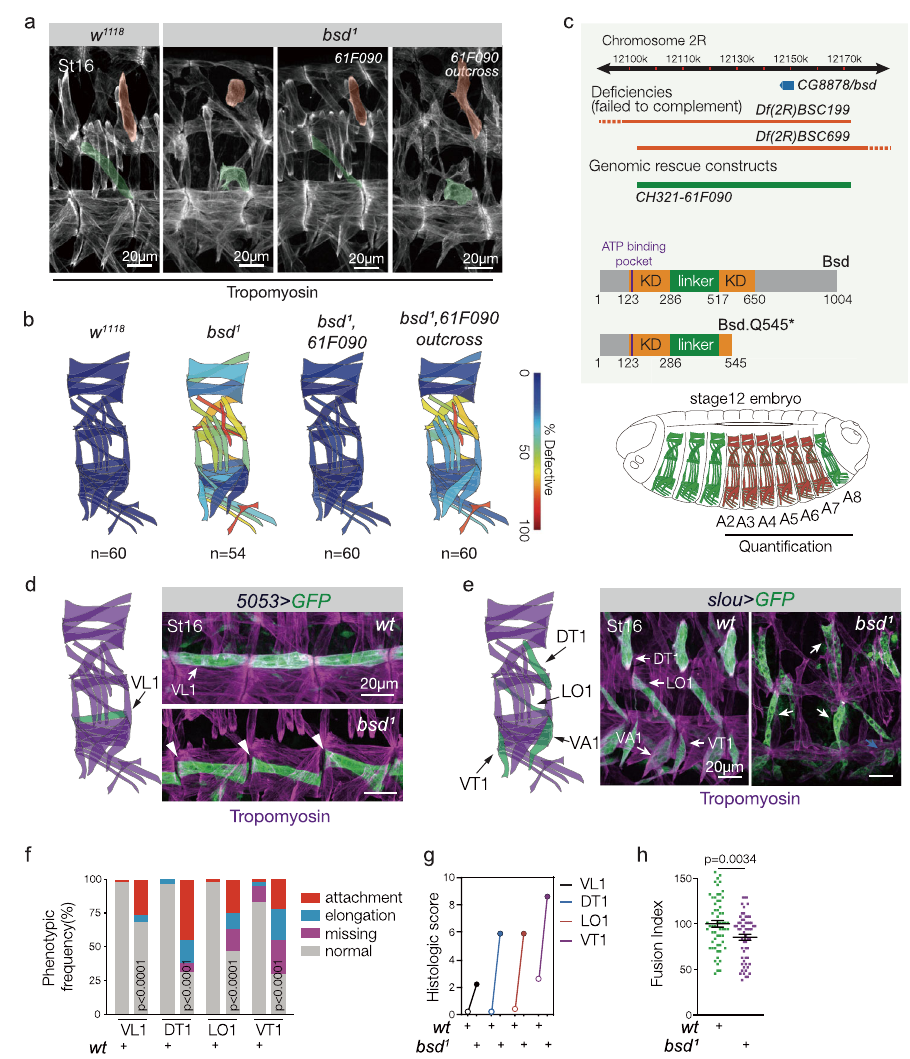
Fig. 1 The ser/thr kinase Bsd regulates muscle morphogenesis. a Myogenic phenotype in bsd 1 mutants. Stage-16 embryos labeled with Tropomyosin. Doral transverse 1 (DT1) and longitudinal oblique (LO1) muscles are pseudocolored. Control ( w 1118 ) embryos showed a stereotypic pattern of body wall muscles. bsd 1 embryos showed severe defects in muscle morphology. bsd 1 myogenic defects were completely rescued in embryos harboring the genomic construct CH321-61F090; outcrossing CH321-61F090 restored the bsd 1 myogenic phenotype. b Quanti fi cation of muscle phenotypes. Muscles were scored in hemisegments A2 – A7 of St16 embryos. Abnormal phenotypes (missing muscles, muscles with attachment site defects, and muscles that failed to elongate) were scored “ defective ” . The frequencies of muscle defects are shown as a heatmap on the stereotypic muscle pattern in one embryonic hemisegment. ( n ) number of hemisegments scored. See Supplementary Fig. 1E for statistical analysis. c Mapping details and Bsd protein domains. Two overlapping de fi ciencies failed to complement bsd 1 (dashed lines indicate breakpoints outside the genomic region shown; see Supplementary Fig. 1 for transheterozygous phenotypes). The Bsd protein has one kinase domain (KD; orange) that is conserved among the VRK protein family; the Bsd KD is divided by a unique linker (green). The position of a conserved ATP-binding pocket is also shown (purple). d , e Stage-16 embryos labeled for 5053 > GFP ( d , green) or slou > GFP ( e ), and Tropomyosin (violet). Ventral lateral 1 (VL1) muscles made incorrect or incomplete tendon attachments in bsd 1 embryos ( d , white arrowheads) and were often rounded (not shown). DT1, LO1, and ventral transverse 1 (VT1) muscles also made incorrect tendon attachments in bsd 1 embryos ( e , white arrowheads; see Supplementary Movie 1) or were rounded (blue arrowhead). f Histogram of muscle phenotypes in 5053 > GFP and slou > GFP embryos ( n = 60 hemisegments per muscle per genotype). g Histologic scores for muscles analyzed in ( f ). Open circles (wild-type), closed circles ( bsd 1 ). h Fusion index in St12 embryos. Myoblast fusion was modestly reduced in bsd 1 embryos. Each data point represents one hemisegment ( n = 60 per genotype). See “ Methods ” for statistical parameters. Signi fi cance determined by two-sided Fisher ’ s exact test ( b , f ), and two-sided unpaired Student ’ s t test ( h ). Error bars represent